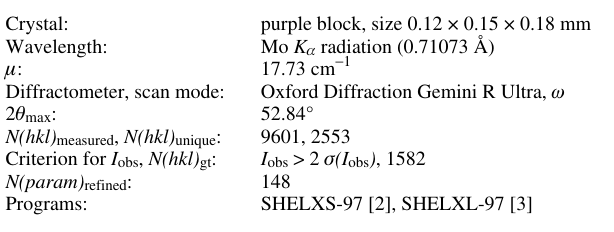
Table 1. Data collection and handling.